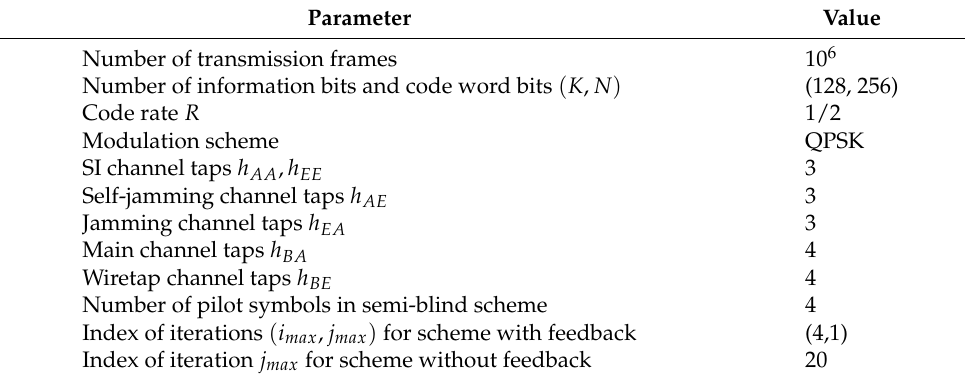
Table 2. Simulation